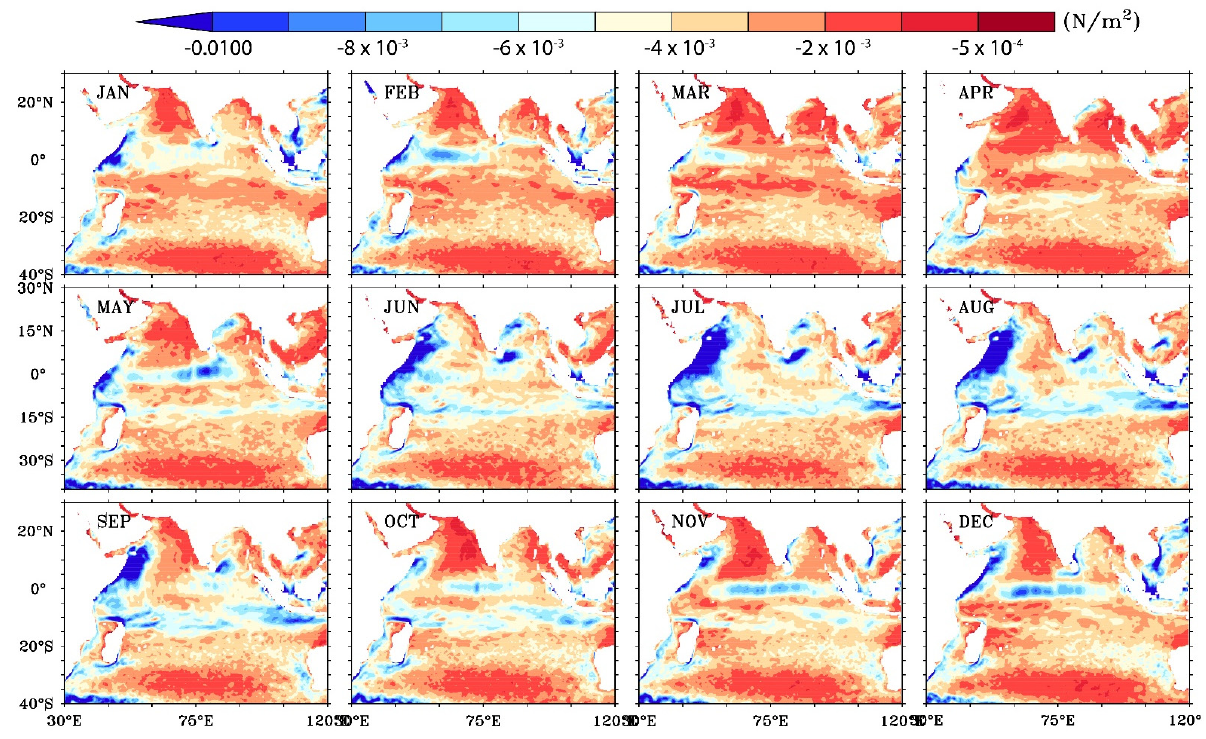
Figure 3. Monthly spatial variation of the difference between two wind stress estimations ( τ Cur − τ no-Cur ) averaged over 2007–2020.